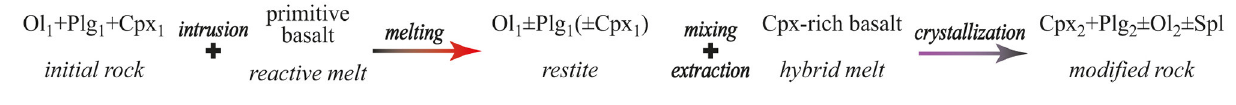
Figure 10 | Reaction showing gabbro (s.l.) partial melting and hybridization with hot mantle-derived melt. The lower oceanic crust gabbro (s.l.) and percolating MOR melts are physically and chemically modified. New and secondary phases will